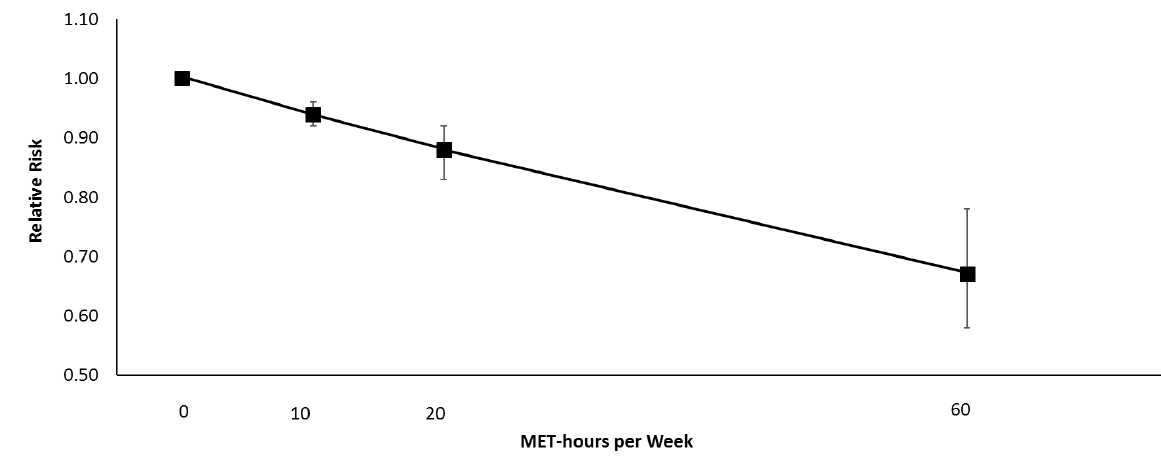
Figure F5-3. Inverse Relationship Between Incident Hypertension and Leisure-Time Physical Activity, by MET-Hours per Week Among Adults with Normal Blood